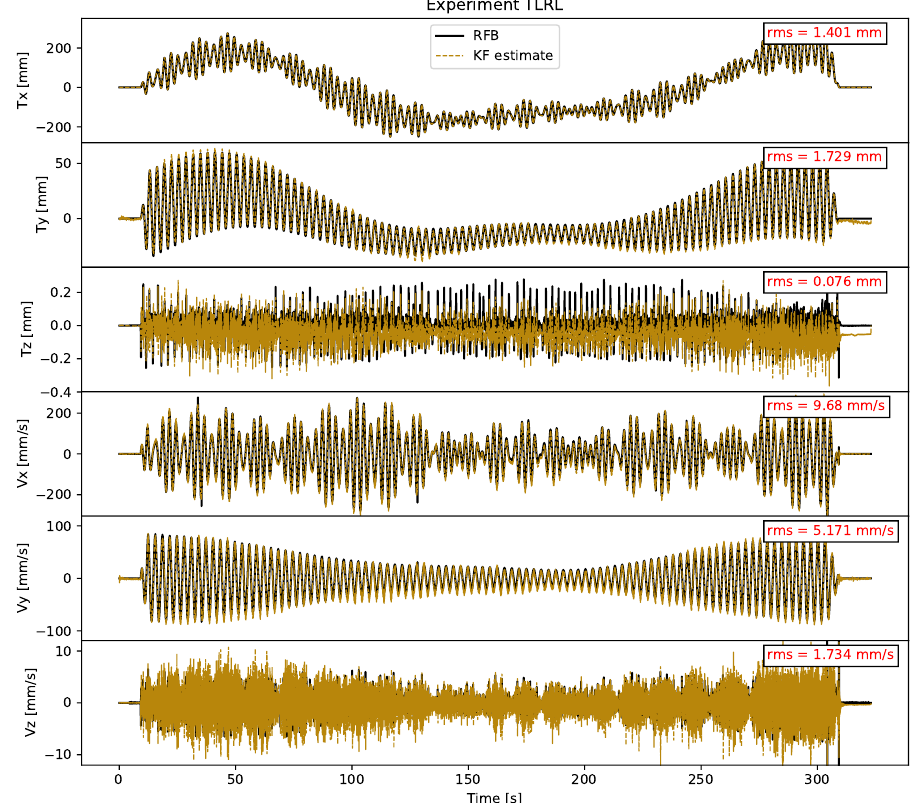
Figure 10. The figure illustrates the time series of the KF estimates for the TLRL experiment in yellow plotted against the robot feedback (RFB) in black. The top three subfigures show the KF displacement estimates versus the RFB. The lower three subfigures show the KF estimated velocities versus the numerically differentiated RFB velocities. In the top right corner of each axis, the RMSE between the RFB and KF state estimates is